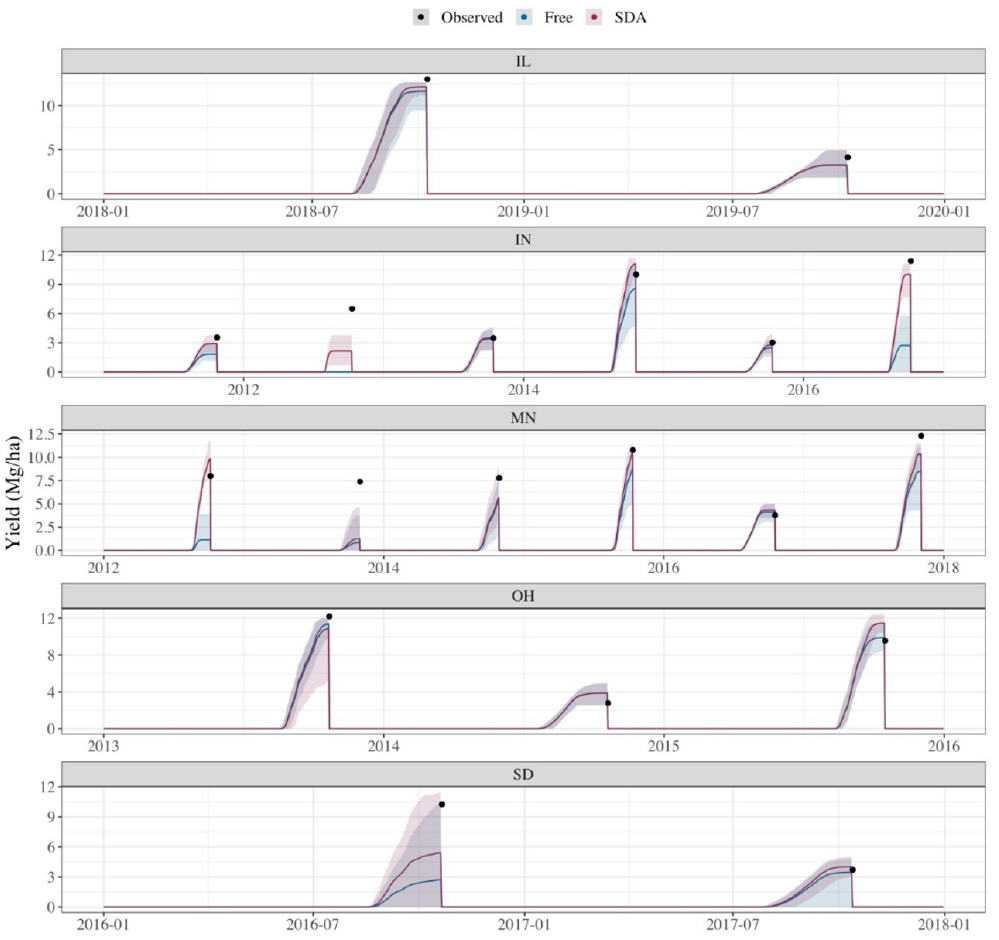
Figure 5. Time series of yield estimates for the free model and in situ SDA with mean daily estimates demonstrated with line graphs and the 95% credible intervals demonstrated by the shaded regions. Black points represent the observed harvest date and yield for each site year.